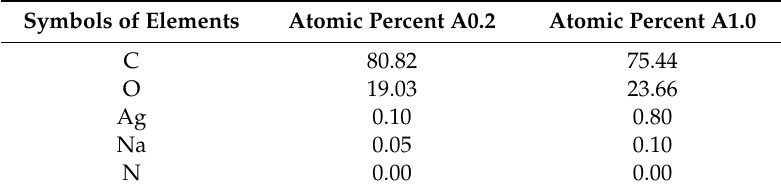
Figure 7. ( a ) SEM and surface mapping (the dotted line presents the path of EDS line scan of samples A0.2), ( b ) EDS analysis of particles (A0.2). The main elements identified in the particles were C, O, Ag, Na (Table 4). Table 4. EDS analysis of samples A0.2 and A1.0.